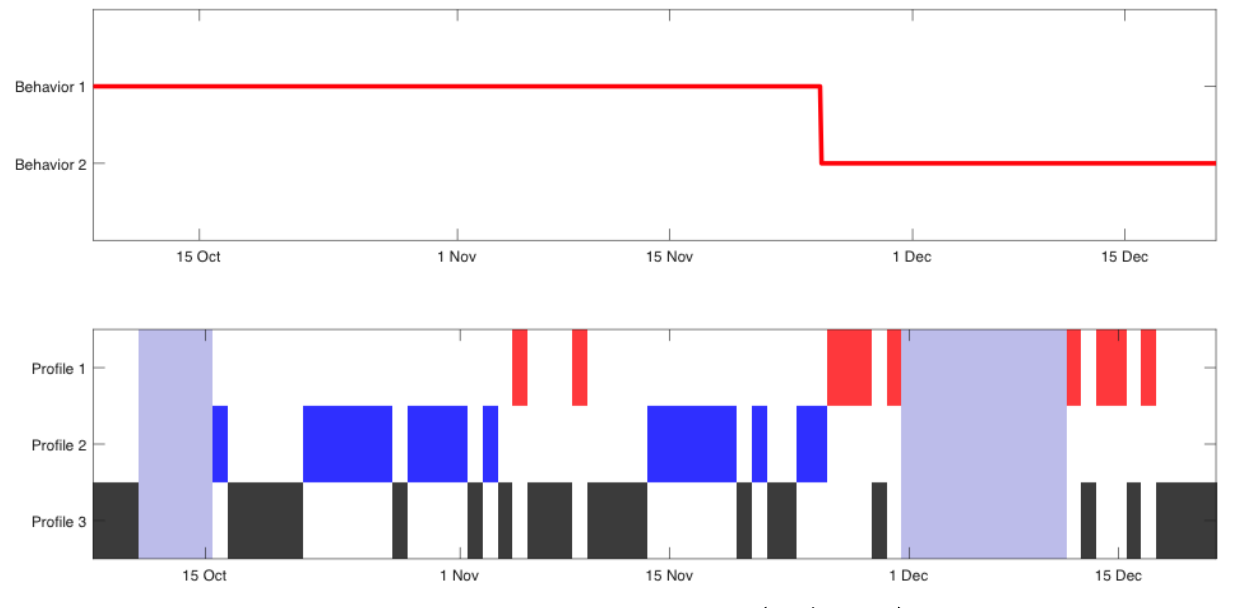
Figure 12. Representation of mobility pattern changes (above) identified by the technique and corresponding patterns (down) during study participation of patient